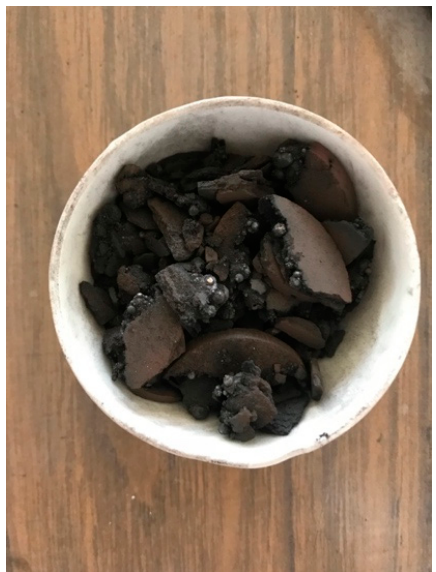
Figure 6. Cinder after 300 seconds, irradiation time at 0.6 kW, C/MBR 0.225 and 1 L/min nitrogen flow.